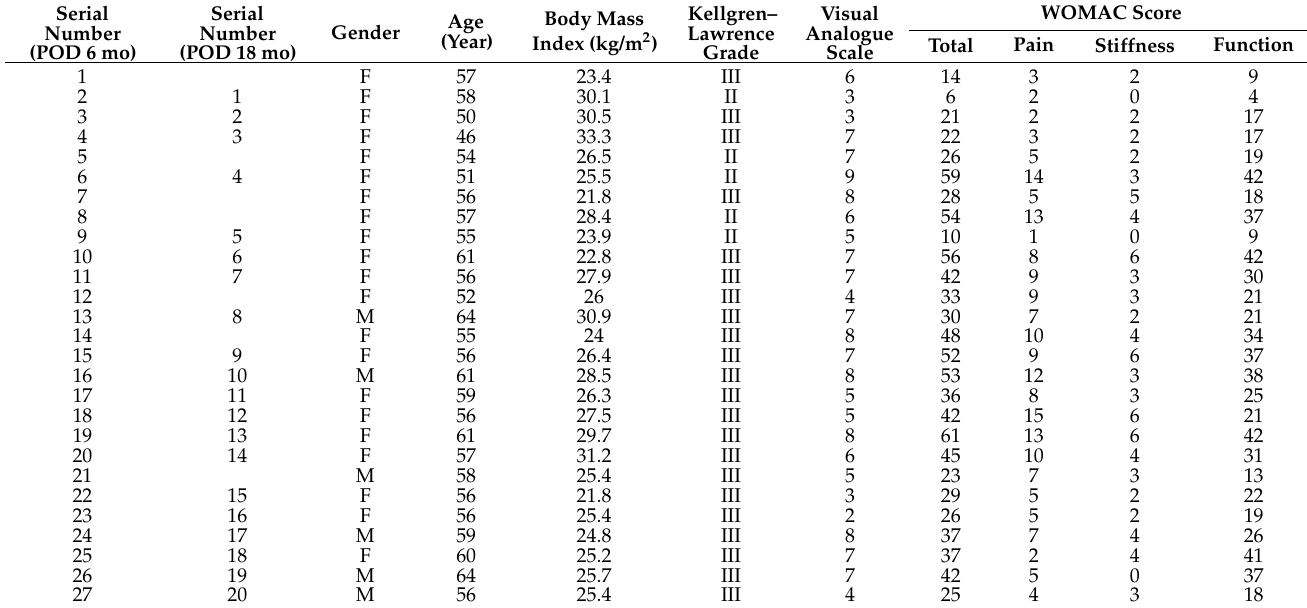
Table 2. Demographic data of 27 patients 6 months after HTO and 20 patients 18 months after HTO at validation